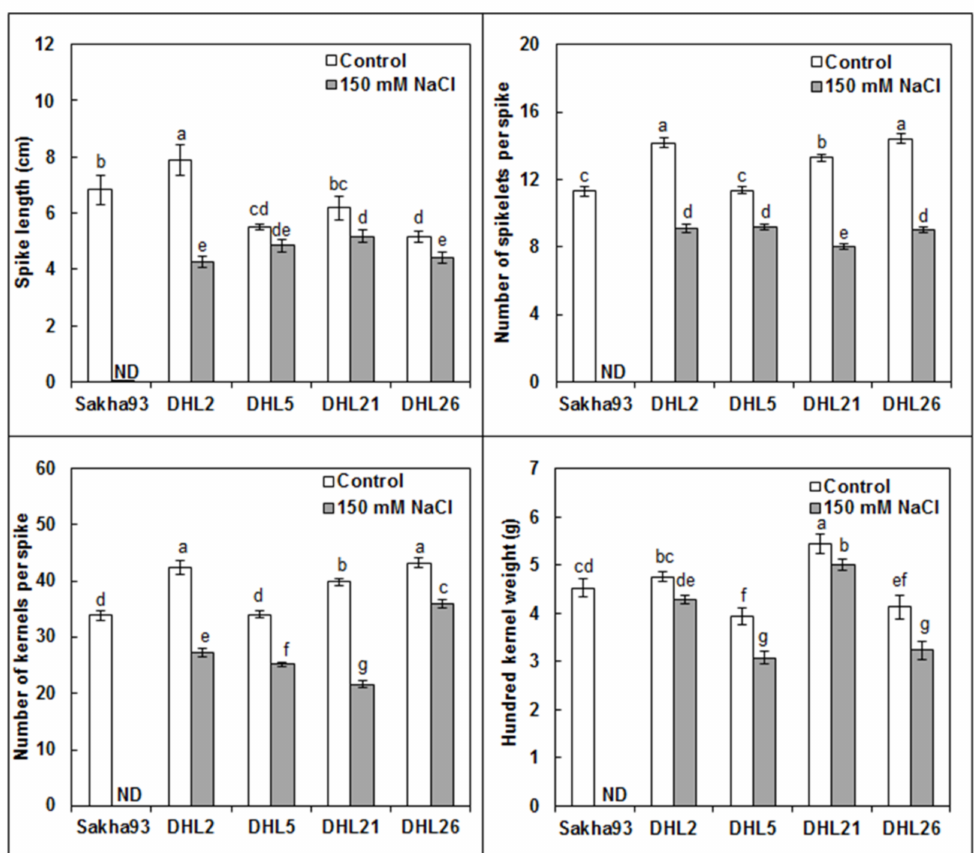
Figure 8. Effects of salinity on yield parameters (spike length, spikelet number, kernel number, and 100-kernel weight) of five wheat genotypes. Values are presented as the mean ± SE of at least three replications, and values sharing the same letter for each treatment × genotype combination are not significantly different ( p ≤ 0.05) according to Duncan’s multiple range